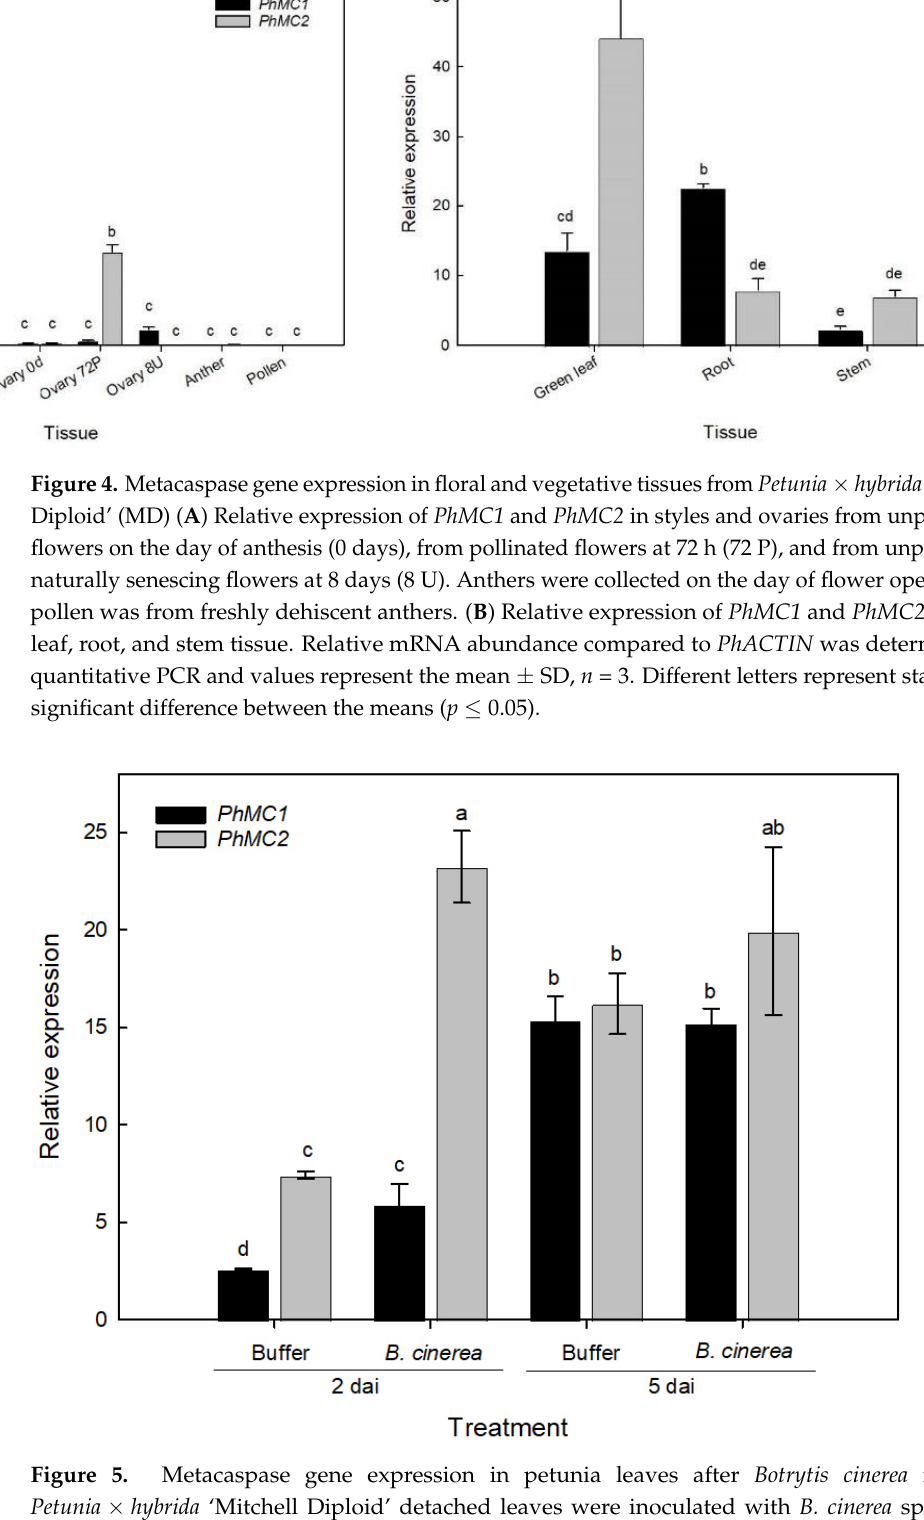
Figure 5. Metacaspase gene expression in petunia leaves after Botrytis cinerea infection. Petunia × hybrida ‘Mitchell Diploid’ detached leaves were inoculated with B. cinerea spores and evaluated at 2 or 5 days after inoculation (dai). Abundance of PhMC1 and PhMC2 transcripts were determined relative to PhACTIN by quantitative PCR. Bars represent mean ± SD ( n = 3). Different letters repre- sent statistically significant difference between the means ( p ≤ 0.05). PhMC1 was more highly upregulated than PhMC2 by various abiotic stresses. When young seedlings were subjected to high salinity (100 mM NaCl) the expression of PhMC1 in the seedling shoots increased by almost 2-fold after 0.5 h (Figure 6). Transcript